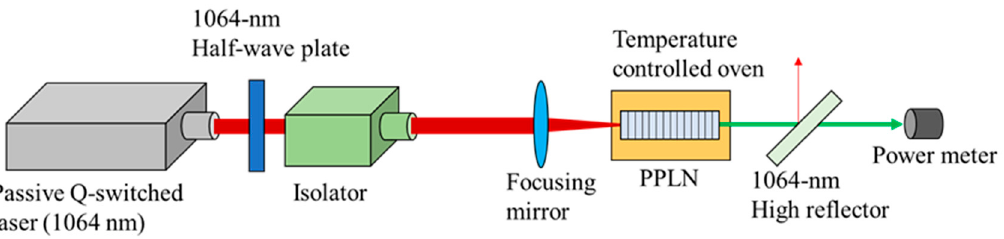
Figure 4. The schematic experimental setup of third-order SHG in radiation-irradiated PPLN. A 1064 nm high reflector was used to remove the un-depleted 1064 nm laser power. The PPLN was in a temperature-controlled oven. A power meter was used to measure the 532 nm laser power. Temperature tuning curves were recorded.